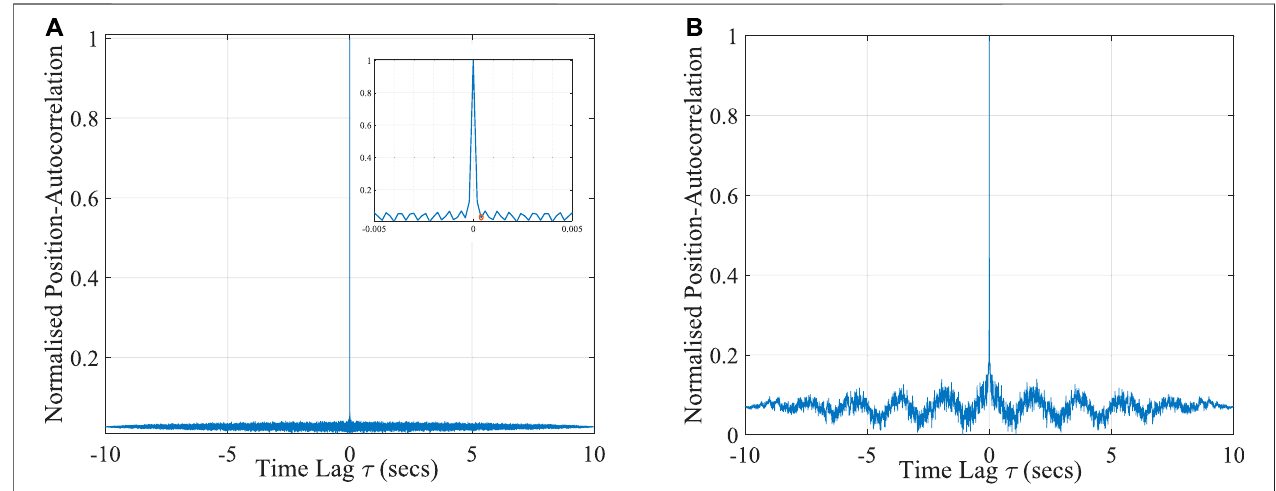
FIGURE5| Normalizedpositionautocorrelationsforvarioustimelagsfor (A) theextractedrandomnoise,and (B) theBrowniantimeseries.Theformershowsnear perfect temporal delta correlation, the later exhibits exponential decay for small time lags, followed by jittery non-monotonicity.